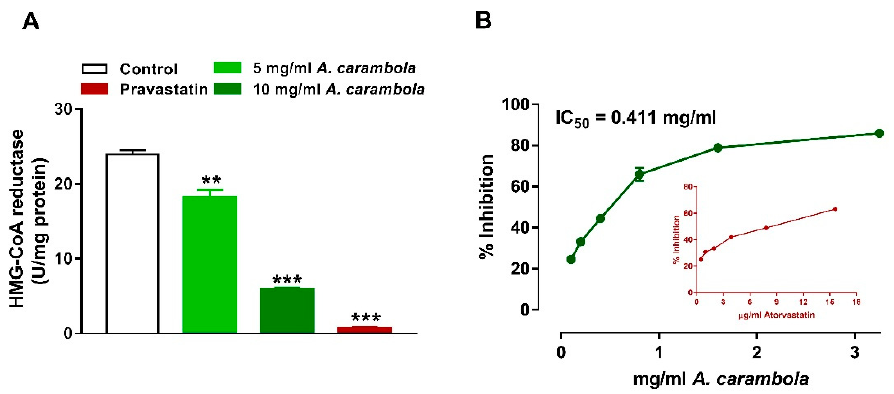
Figure 5. Inhibitory activity of MEACL on HMG-CoA reductase ( A ) and pancreatic lipase ( B ). ** p < 0.01, *** p < 0.001 compared to Control.